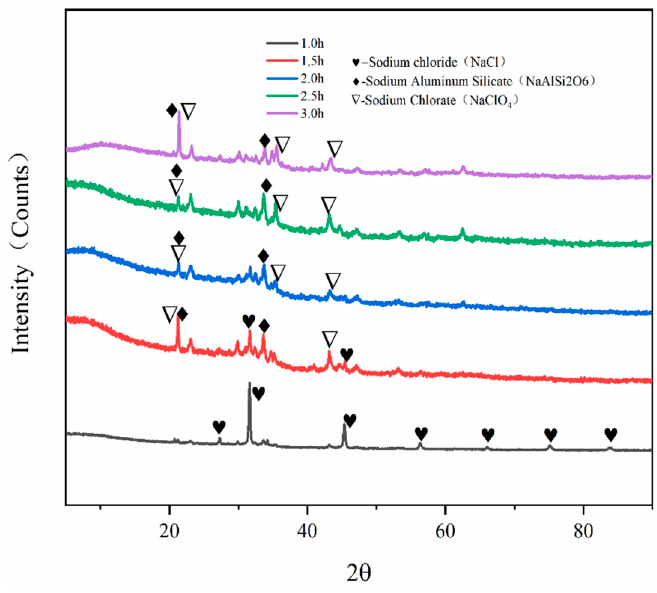
Figure 11. The effect of melting time over: ( a ) Cl and Na content in slag; ( b ) Pb and Zn content in slag; ( c ) ignition loss ratio and slag ratio; and ( d ) distribution ratio of Cl, Na, Pb, and Zn in soot. With the extension of smelting time, the distribution ratio of Cl and Na in soot in- creased gradually, and almost reached the maximum at 2.5 h. When the melting time was 2.5 h, the content of Cl and Na in the slag was 0.50 wt.% and 12.47 wt.%, respectively, and the corresponding distribution ratio was as high as 98.64% and 66.16% in the dust, respec- tively. Most of the Cl in the fly ash had migrated to the gas phase, while a certain amount of Na remained in the glass slag. The XRD spectra of the slag obtained from different melting times are shown in Figure 12.